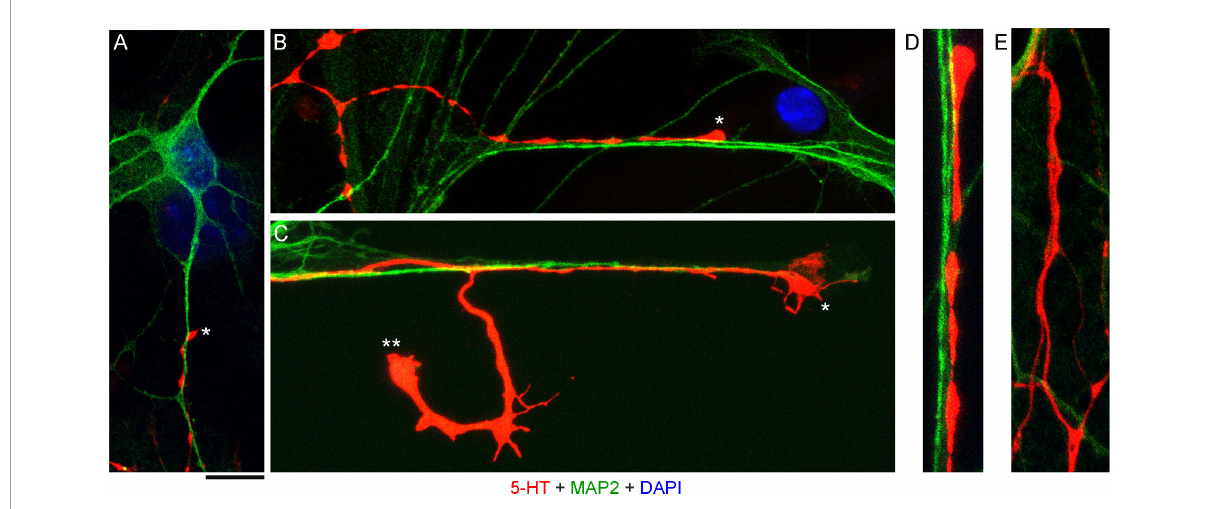
FIGURE2 Primary midbrain cultures, visualized with immunocytochemistry for 5-HT (red) and MAP2 (green) and imaged with high-resolution confocal microscopy. Cell nuclei are stained blue (DAPI). (A) A serotonergic axon (5-HT + /MAP2 -, asterisk) that advances along a dendrite of a non-serotonergic neuron (5-HT -/MAP2 +). (B) Another serotonergic axon (5-HT + /MAP2–, asterisk) that advances along a 5-HT–/MAP2 + neurite. (C) A serotonergic axon (5-HT + /MAP2–, asterisk) that advances to the end of a 5-HT –/MAP2 + neurite and also produces a branch that has lost contact with the neurite (double asterisk). Note the much larger caliber of the branch, as well as multiple growth cone-like zones, perhaps in search of the next attachment point. (D) A typical contact between a serotonergic axon (5-HT + /MAP2–) and a 5-HT–/MAP2 + neurite (an enlarged part of B). (E) Contacts between two serotonergic axons (5-HT + /MAP2–) are less frequent but also occur, with no apparent repulsion between the axons. (A,B,D,E) Monolayers at DIV 4; (C) neuron-glia co-culture at DIV 3. Scale bar (shared by all panels) = 10 µ m in (A–C) ; 5 µ m in (D,E) .